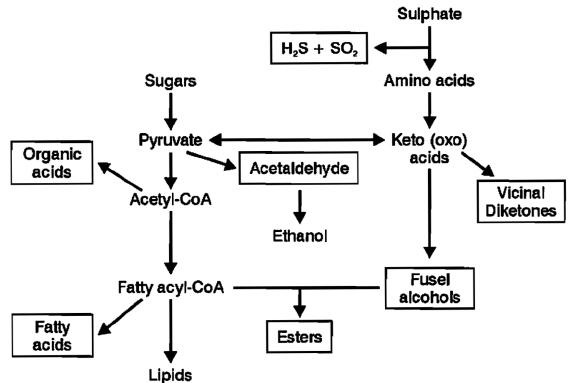
Figure 2. Major metabolic routes by which brewer’s yeasts synthesize fusel alcohols, esters, sulphur compounds, VDKs, acetaldehydes and ethanol [1].